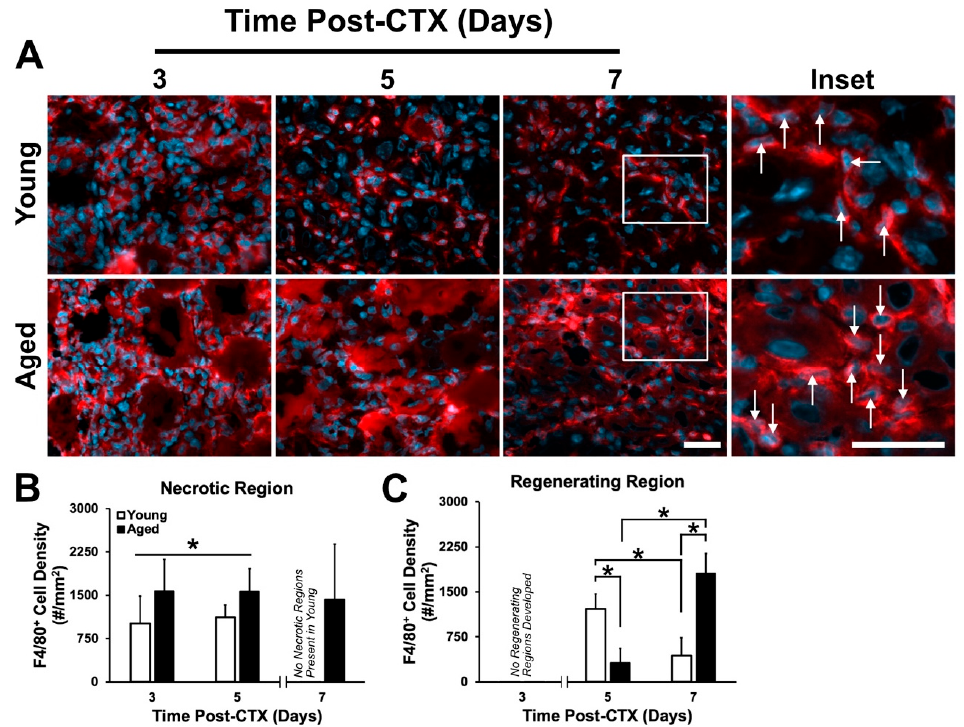
Figure 7. Macrophage responses to skeletal muscle differ between young and aged skeletal muscle. ( A ) Immunostaining of F4/80 (red) and DAPI (blue) used to identify macrophages. White arrows indicate F4/80+ cells (macrophages). White frame indicates region of higher magnification shown in neighbouring inset. Scale bars both represent 50 μ m. ( B ) Macrophage density was greater in the necrotic region of aged muscle and remains steady between three to five days following damage. * denotes significant main effect of age ( p = 0.025). ( C ) A significant interaction between age and recovery time point following damage was observed ( p < 0.001). Simple main effect post-hoc analysis revealed a significant difference in macrophage density at five days following damage, with young muscle having greater density ( p < 0.001). However, at seven days following damage, macrophage density in aged muscle was greater than young ( p < 0.001). A significant drop in macrophage density between five and seven days in young muscle was observed ( p = 0.001), while the opposite was observed in aged muscle ( p < 0.001). The * indicates significant differences detected by a simple main effects post-hoc analysis ( p < 0.05). n = 4–5 per group. Data presented are means ± standard deviation.